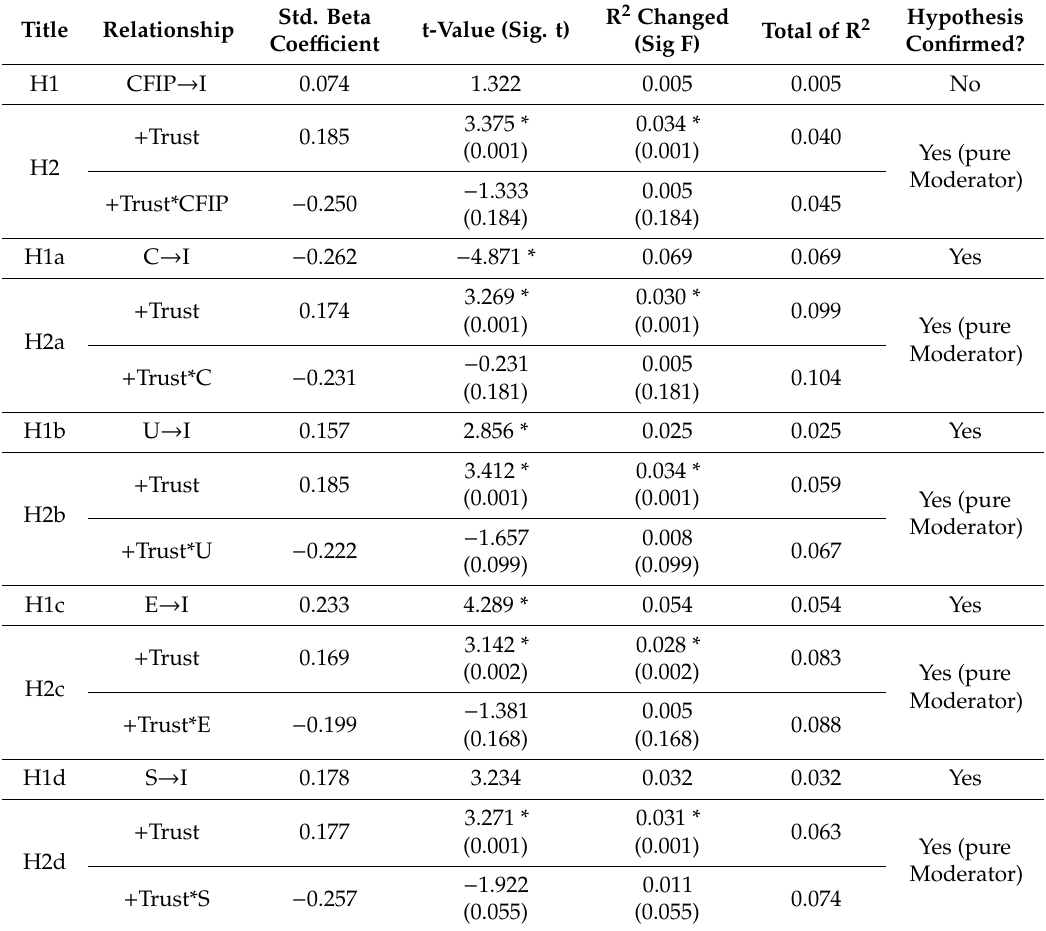
Table 6. Moderator Regression Analysis